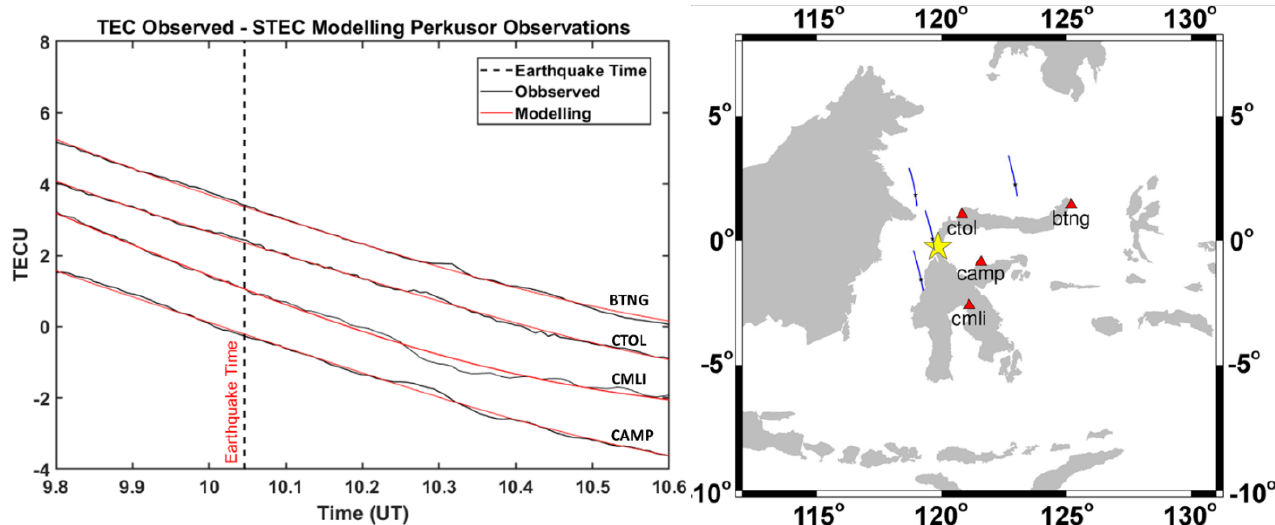
Figure A2. The slant of TEC changes before and after the 2018 Palu earthquake measured from CTOL, CMLI, CAMP, and BTNG stations using GPS PRN 21 ( left ). The variation of TEC slant (black) modelled with polynomial degree up to 6 (red). The strong positive peak shows the earthquake CID (indicated by the blue circle). The black vertical dashed lines in the time series indicate the time of the 2018 Palu Sumatra earthquake mainshock (10:02:45 UT). Furthermore, on the trajectories of GPS PRN 21 ( right ), small red stars indicate the SIP at the mainshock event. The yellow star indicates the epicenter, while the red triangle indicates GPS stations.